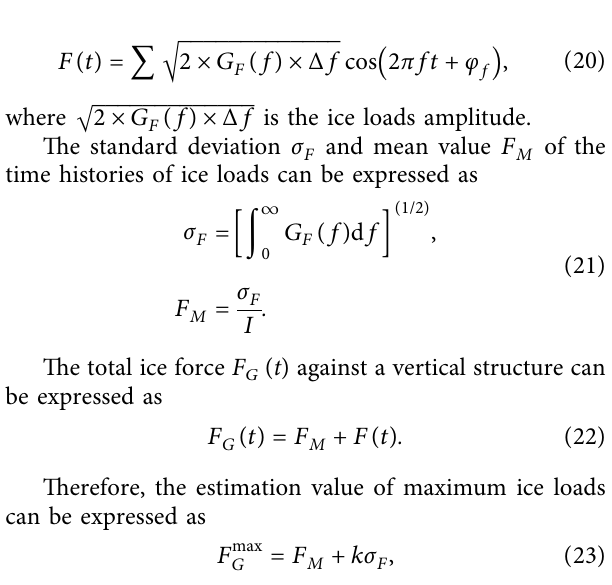
Figure 7: Probability density of ice parameters of JZ20-2 sea area in Bohai Sea: (a) probability density of ice thickness; (b) probability density of ice velocity; (c) probability density of ice